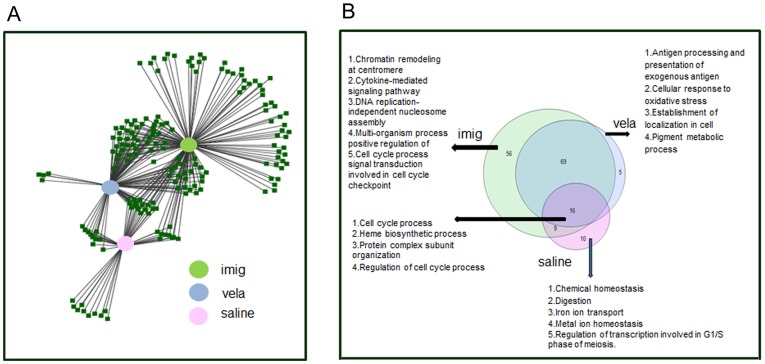
Functional classifications of the DEGs in spleen.(A) Functional relationship of spleen core DEGs associated with each treatment. An abstracted view shows the interaction of the biological functions by the core DEGs in 9V/null spleen compared with WT under different treatment conditions. The biological functions associated with the core DEGs from saline (pink node), vela (blue node) and imig (green node) treated 9V/null mouse spleens. Merged nodes indicate the shared functions between treatments. (B) 3-way Venn diagram presents the distribution of the biological functions by the core DEGs in spleen with different treatments. Each color represents a treatment as labeled. The GO were identified with DAVID. There were 16 functions common for 3 treatments. The unique functions for saline were 10, imig were 4, and vela were 56. The top biological functions are listed against each treatment.